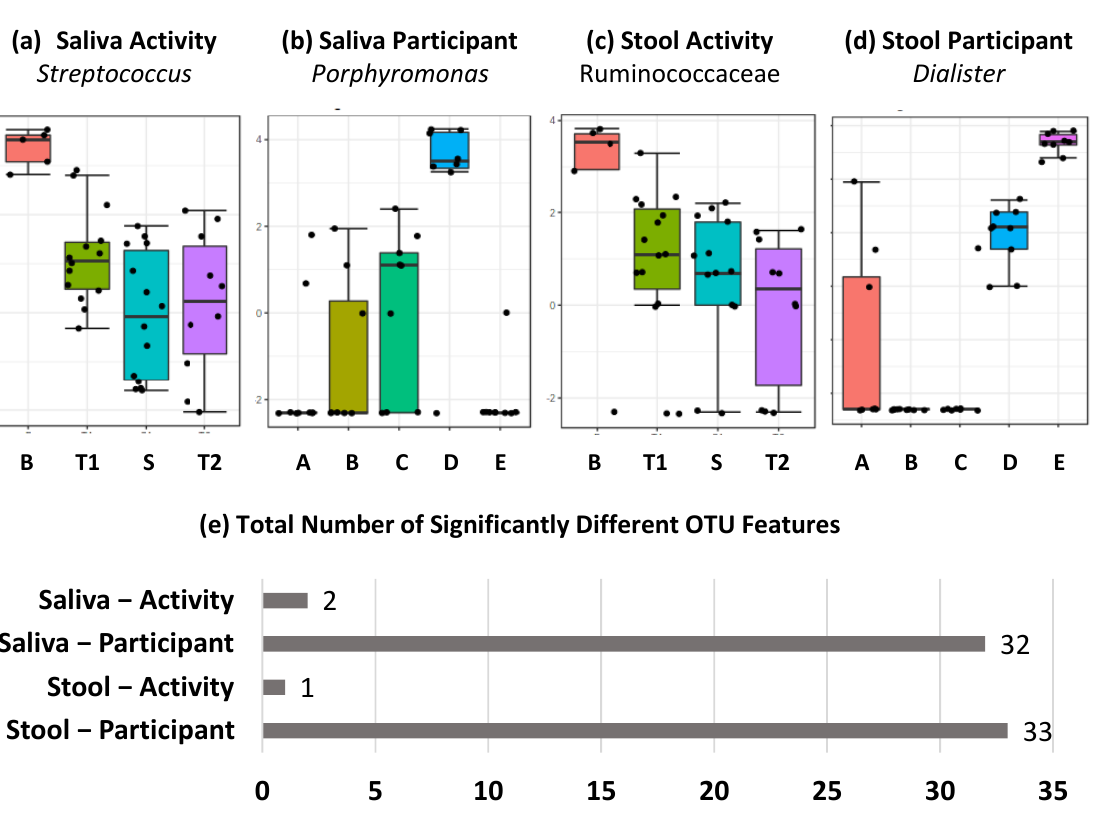
number. Statistical significance indicated by * = p < 0.05; ** = p < 0.01; and *** = p < 0.001.